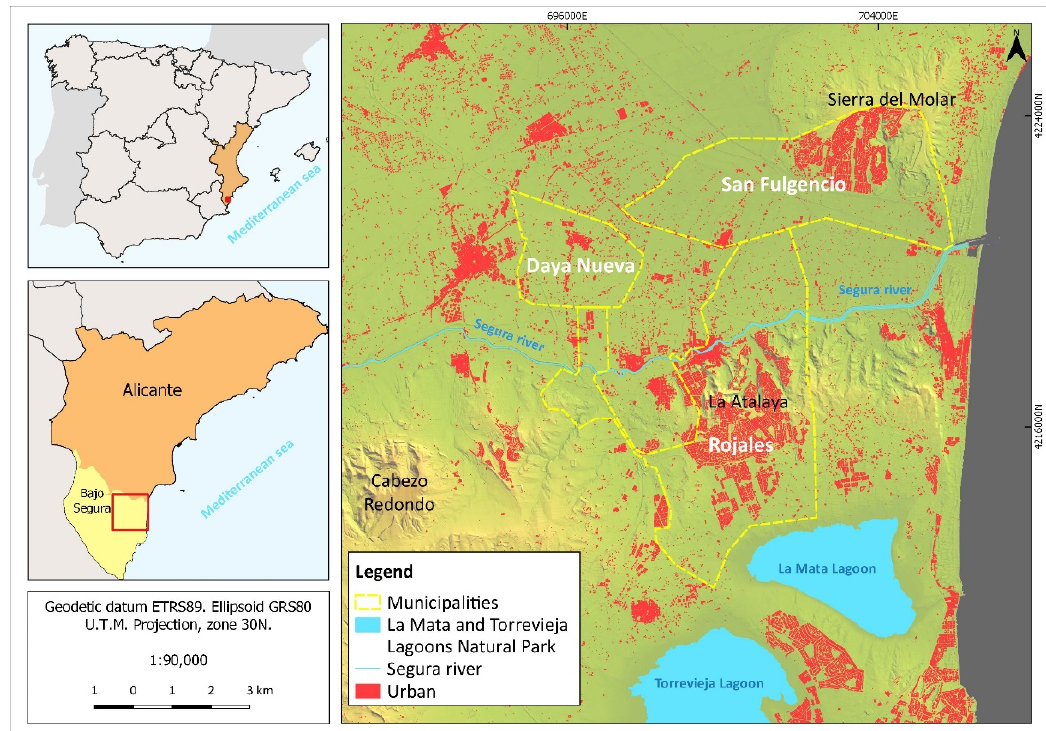
Figure 1. Location of the cases studied. Source: Instituto Cartográfico Valenciano (ICV). Own elab- oration.